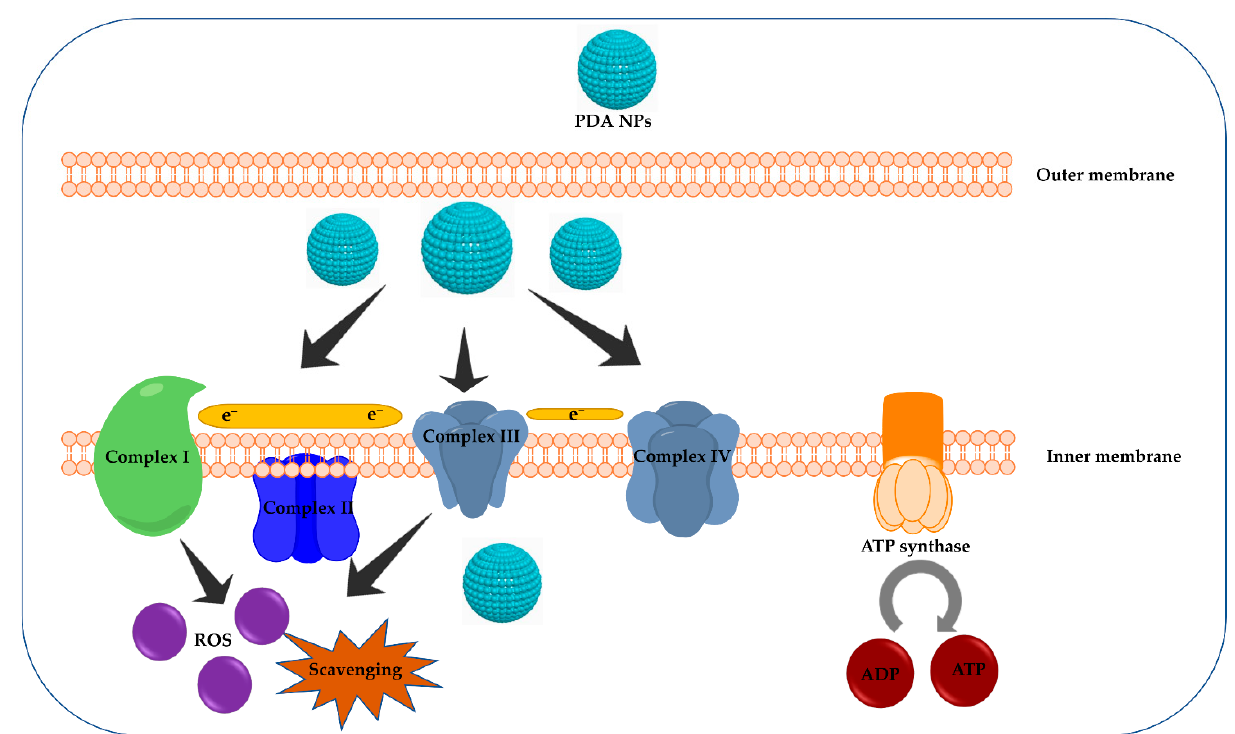
Figure 7. Illustration of PDA NPs as ROS scavengers and as regulators of cellular powerhouses (mitochondria) to reduce osteochondral inflammation.